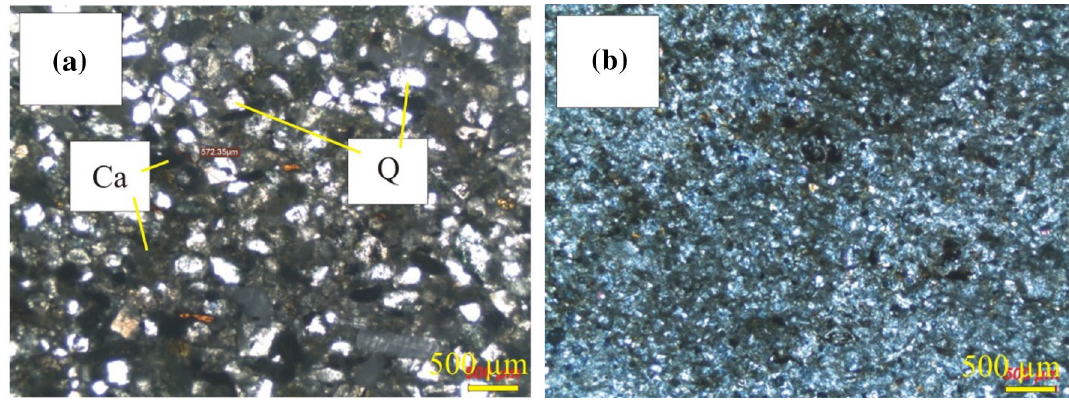
Fig. 7 Micrographs of the Haymana Formation sandstones. a Litho- facies B sandstones are fine grain size (0.2 mm), and moderately sorting, subangular-subrounded grains. Carbonate cement occurs Fig. 6a). Lithofacies A may have experienced dissolution of late calcite cement (Fig. 6b, d). The Lithofacies A sandstones exhibit large and clean pores. The pore shapes are highly variable and display